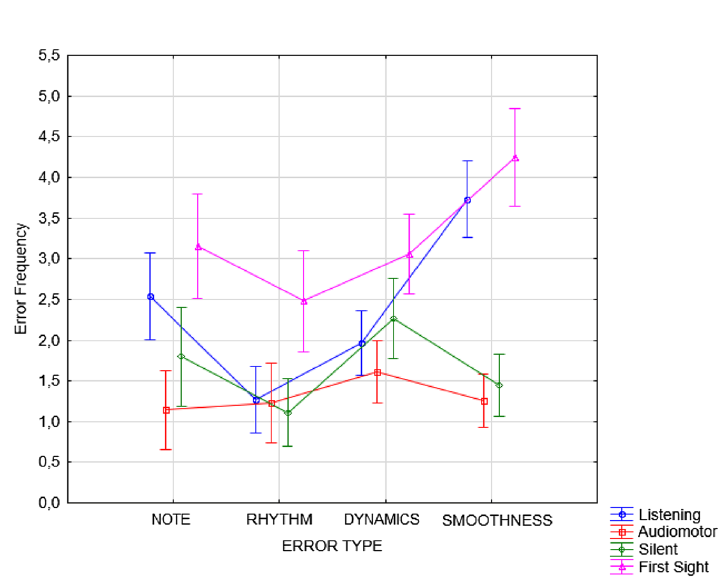
Figure 7. Error frequency observed for the different types of errors committed in the various learning conditions, regardless of the students’ level and instrument played. Error bars indicate standard